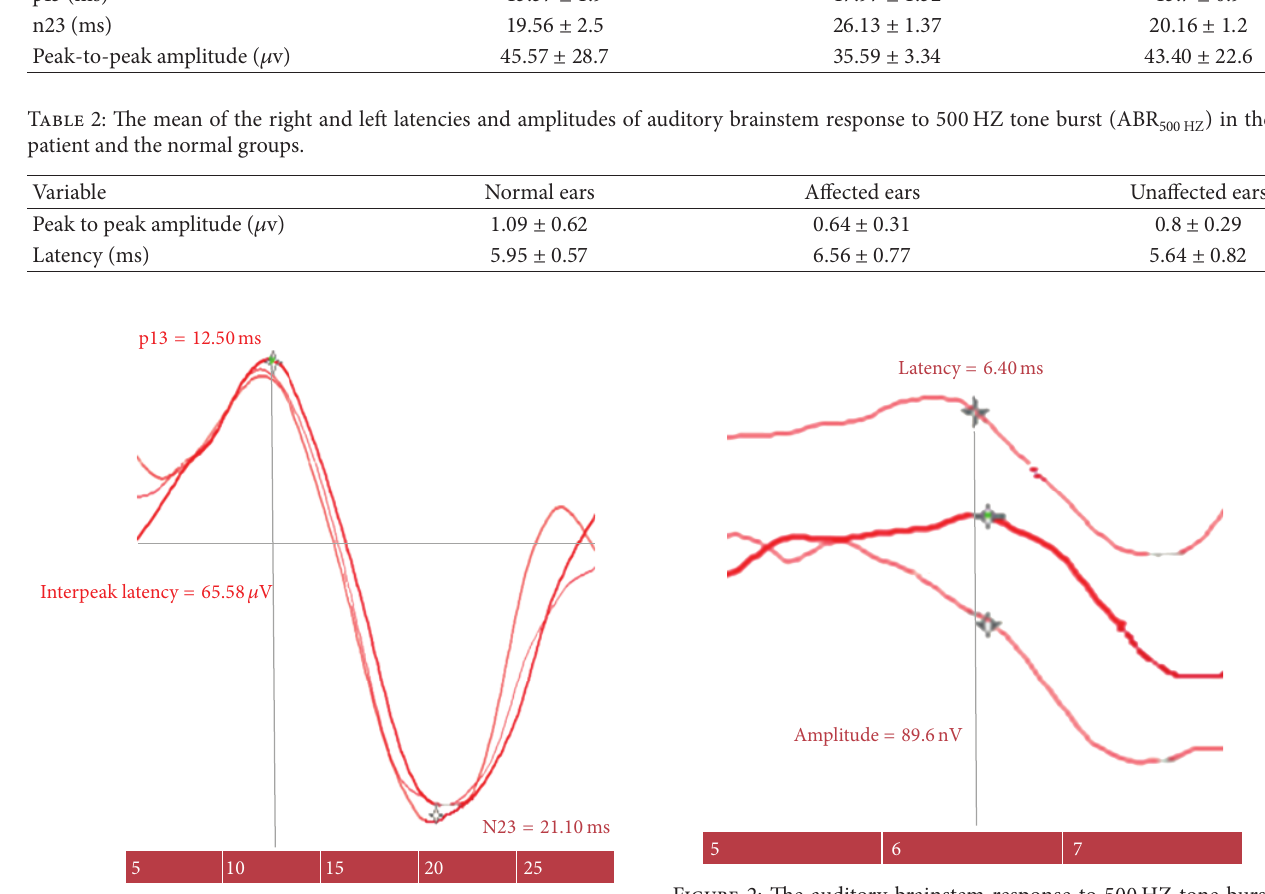
Figure 1: The cervical vestibular evoked myogenic potentials (cVEMPs) in an healthy person.